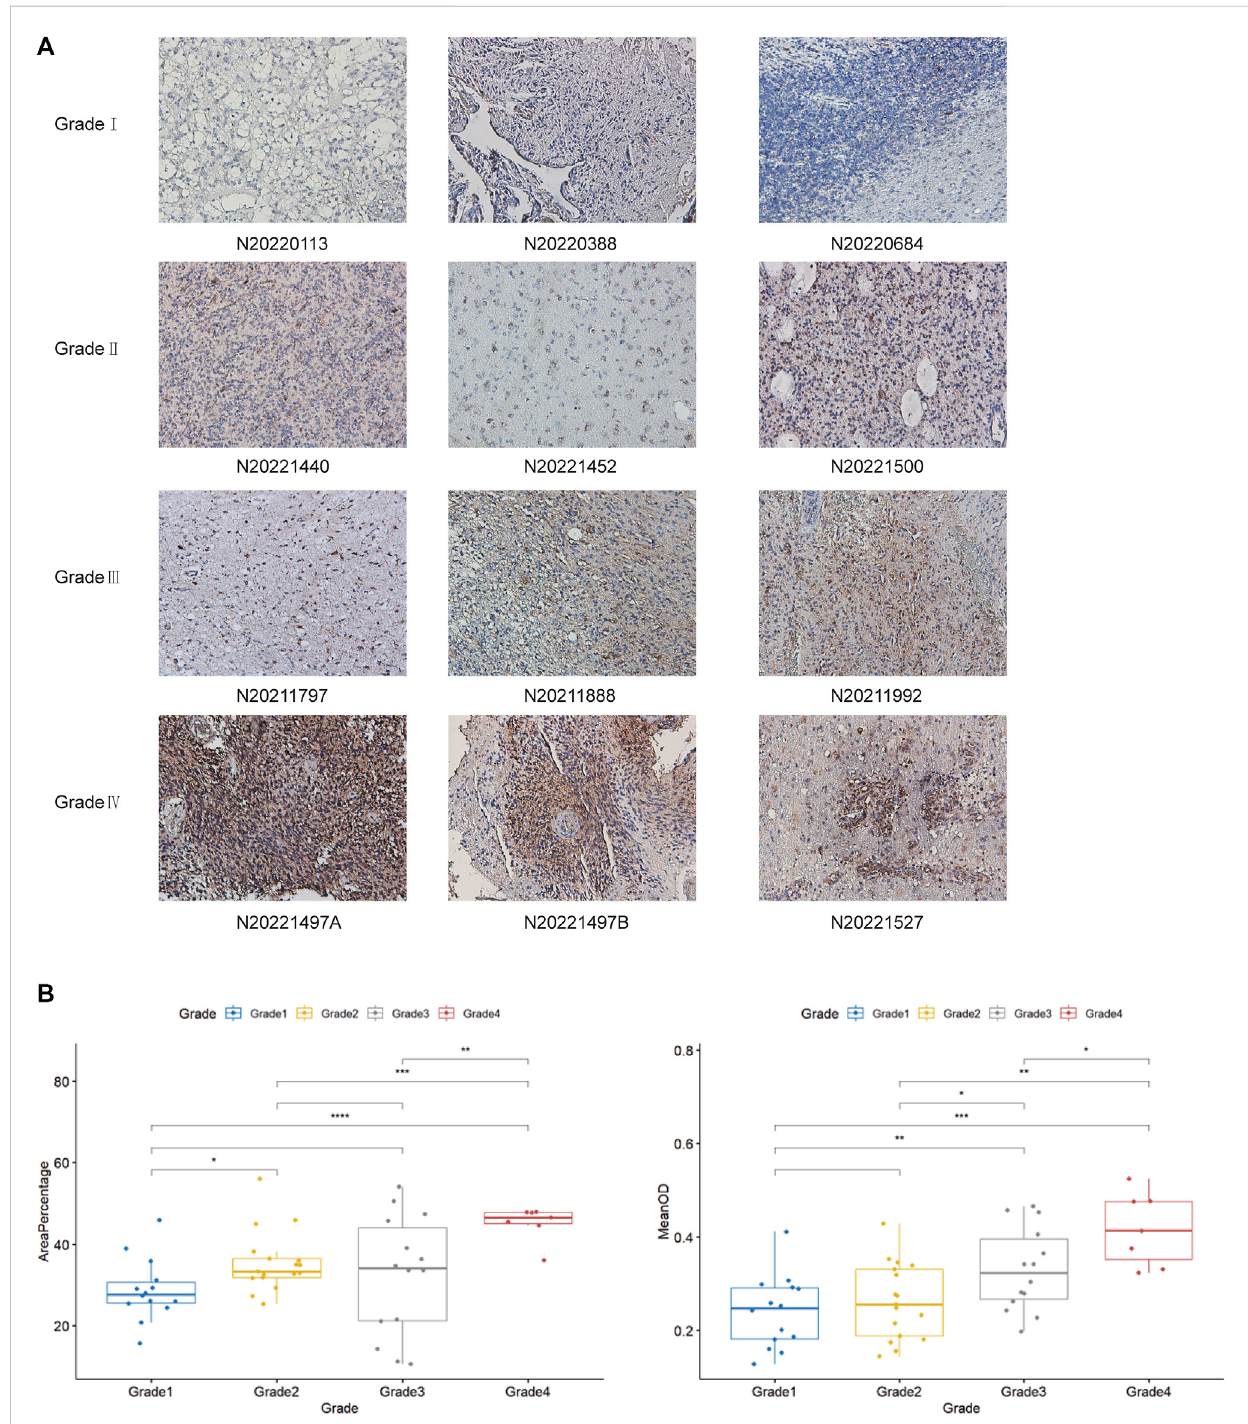
FIGURE 15 (A) Examination of DLD expression in each grade of glioma tissue by IHC analysis. (B) Analysis of DLD expression in each grade of glioma tissue by Student ’ s t -test. They include the percentage of positive area and The mean optical density values. *** p < 0.001; ** p < 0.01; * p <